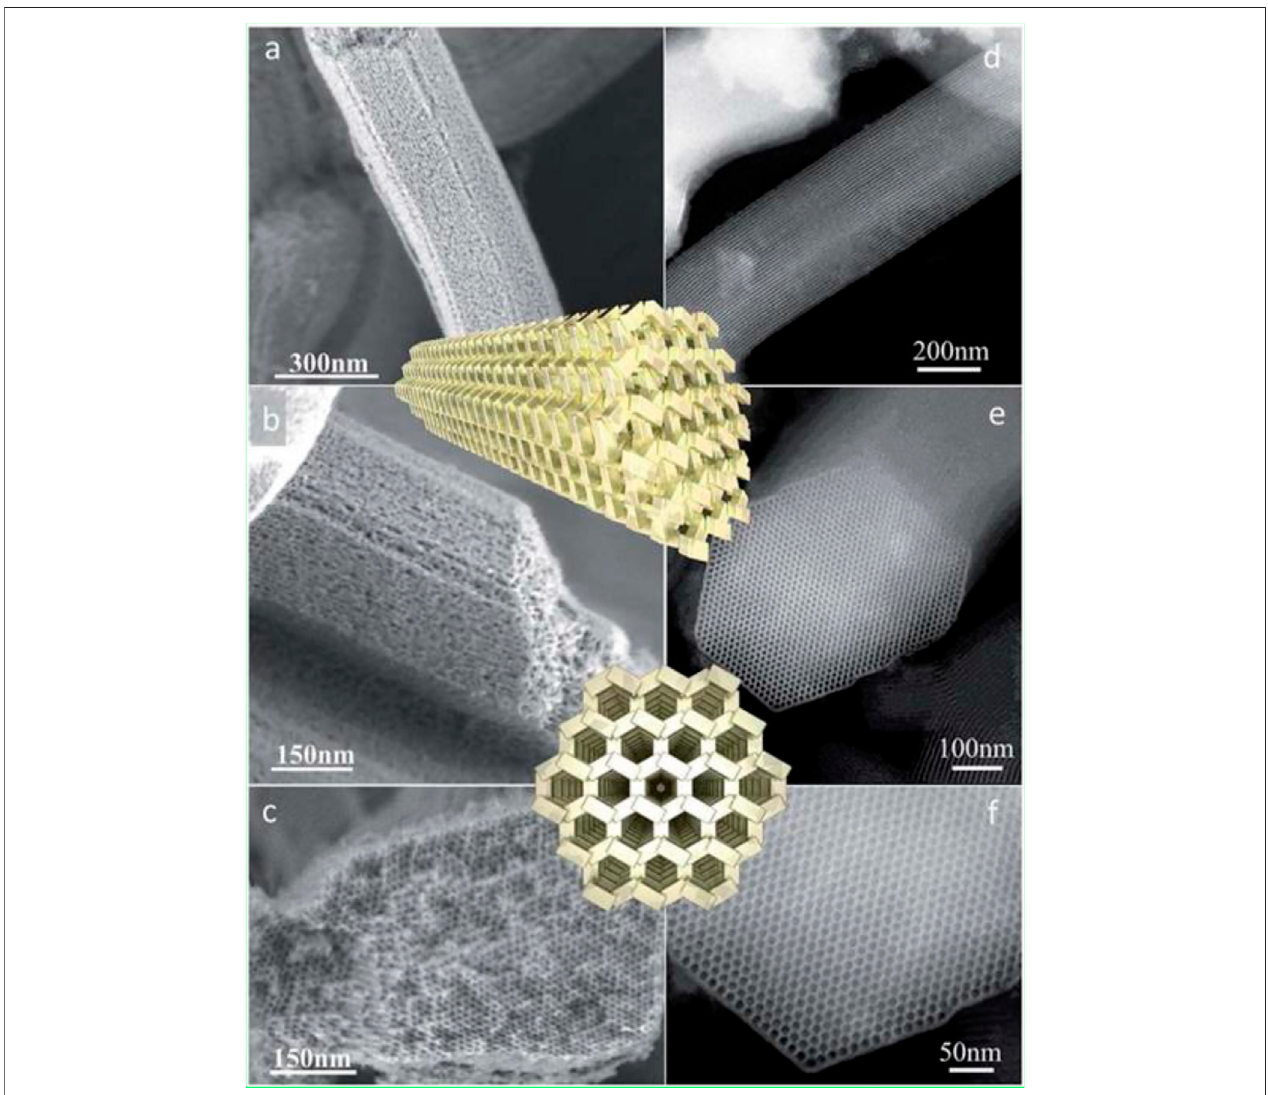
FIGURE4| HR-SEMimagesofazeotile-4sample: (A,B andb)Lateralviewofslit-likeand (C) axialviewofhexagonalmesopores.HAADF-STEMimagesofzeotile- 4particles: (D) lateralviewand (E,F) axialviewwithanoverlayofaschematic(reproducedfromPulinthanathuSreeetal.,2017withpermissionfromtheRoyalSocietyof